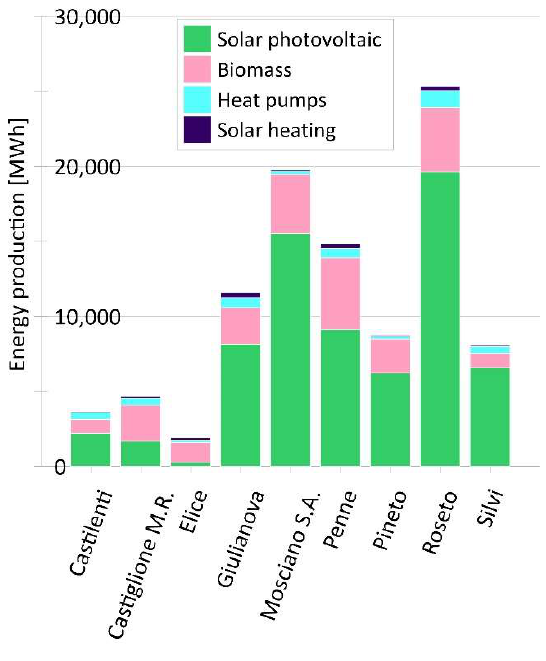
Figure 4. Trend in renewable energy production for each city. The difference in consumption from 2005 to 2018 was calculated with the methodology developed. For every town considered, a reduction of − 5.6% to − 15.6% was experienced. A higher reduction was calculated in Penne, while a lower reduction was seen for Elice (Table 6). The reduction of per capita consumption was calculated and is shown in Figure 5: the city with the greatest per capita reduction in consumption was Mosciano Sant’Angelo ( − 4.13 MWh/inhabitant); the one with the lowest reduction was Castilenti ( − 0.26 MWh/inhabitant). The per capita consumption in 2018 ranged from 20.1 MWh/inhabitant (Silvi) to 25.61 MWh/inhabitant (Castiglione Messer Raimondo). Table 6. Consumption for every city (MWh) and reduction as a percentage.